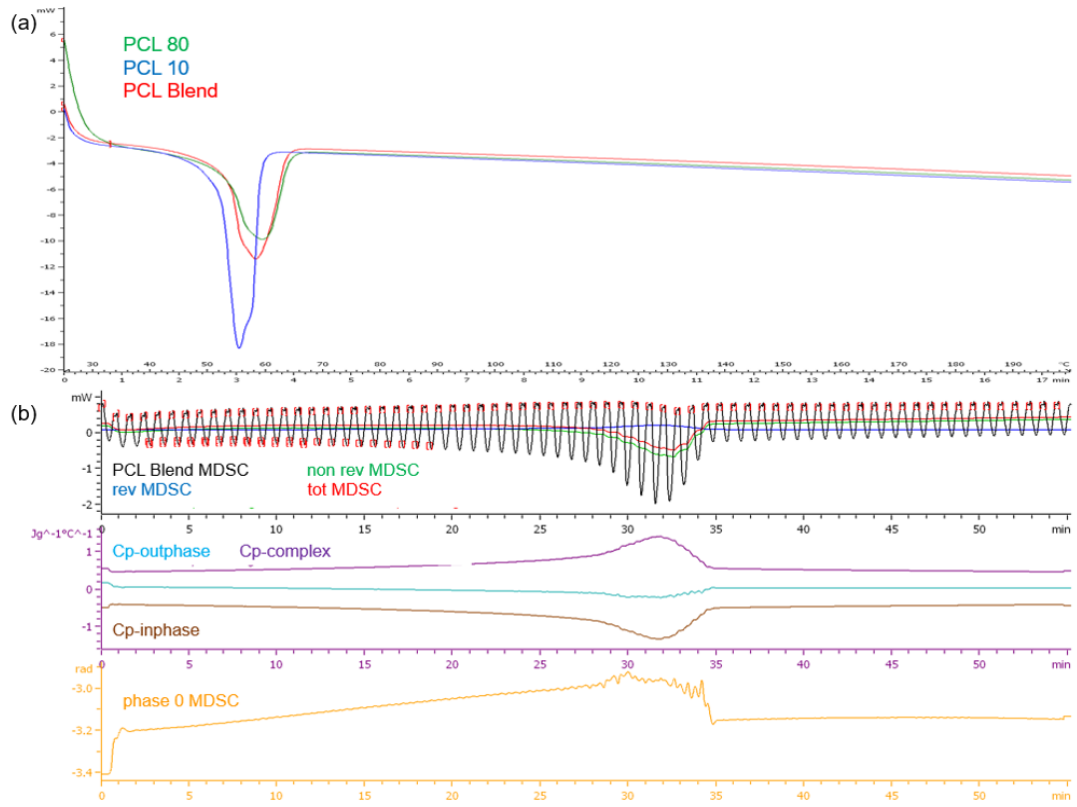
Figure 4. Thermograms of ( a ) the PCL 10 , PCL 80 and PCL blend DSC profiles and ( b ) the TMDSC profile of the PCL blend.